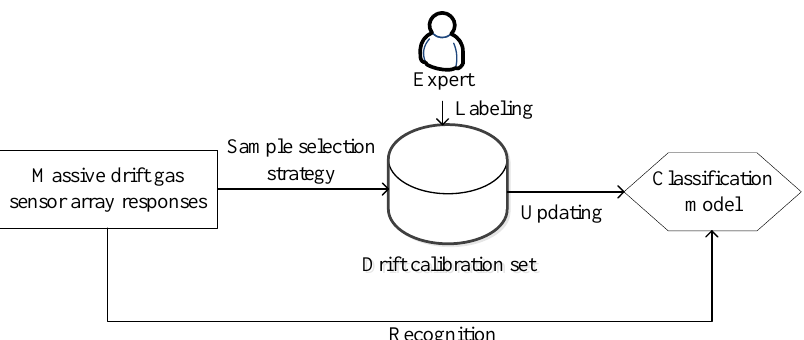
Figure 1. Active learning-based drift compensation.